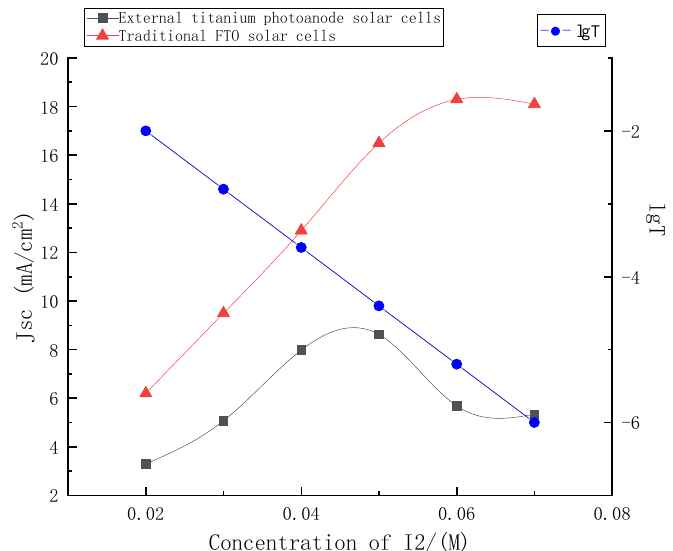
Figure 7. Change curve of short-circuit current density between traditional FTO solar cells and external titanium photoanode solar cells.